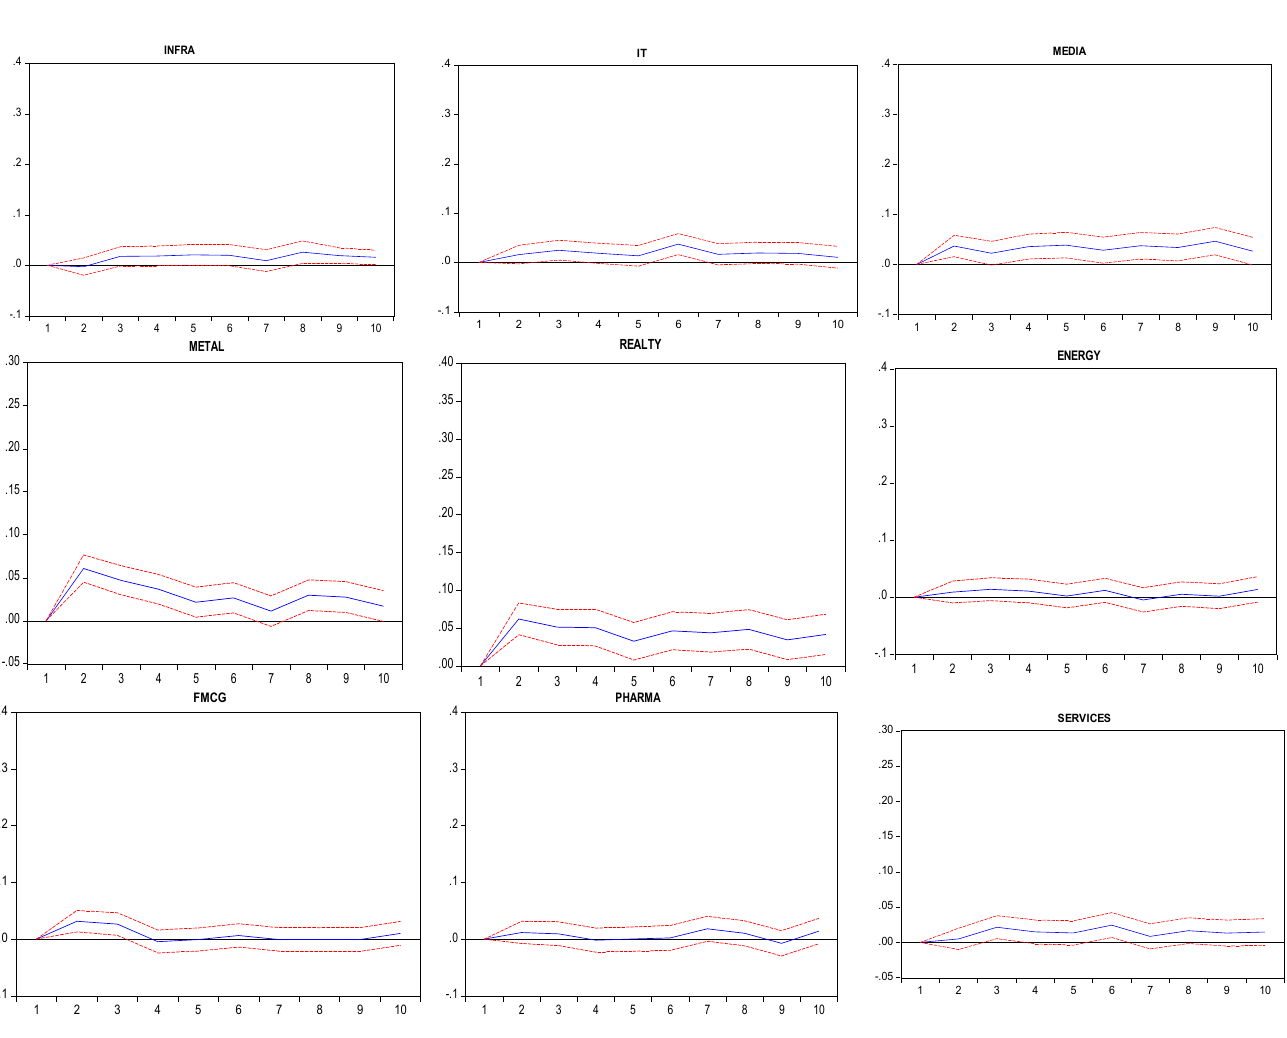
Figure 1. Market volume responses to market return shocks for the cyclical and defensive sectors (pre ‐ COVID ‐ 19 period).